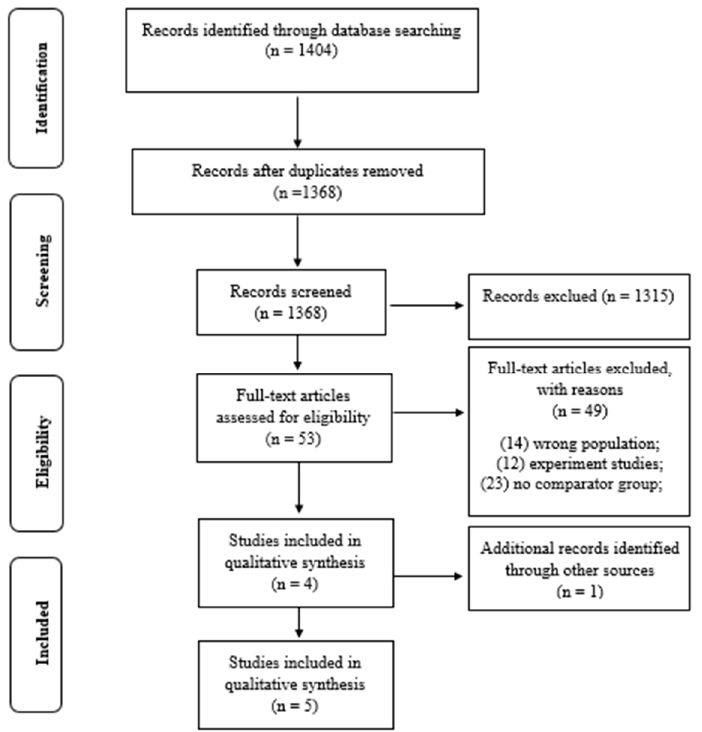
Figure 1. Search and selection of studies for systematic review according to PRISMA.